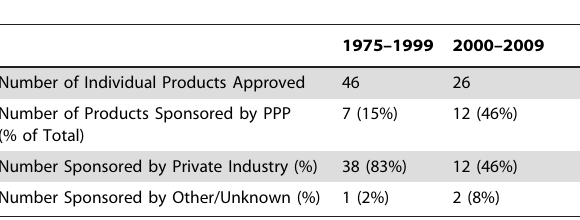
Table 3. Comparison of Approvals by Source of